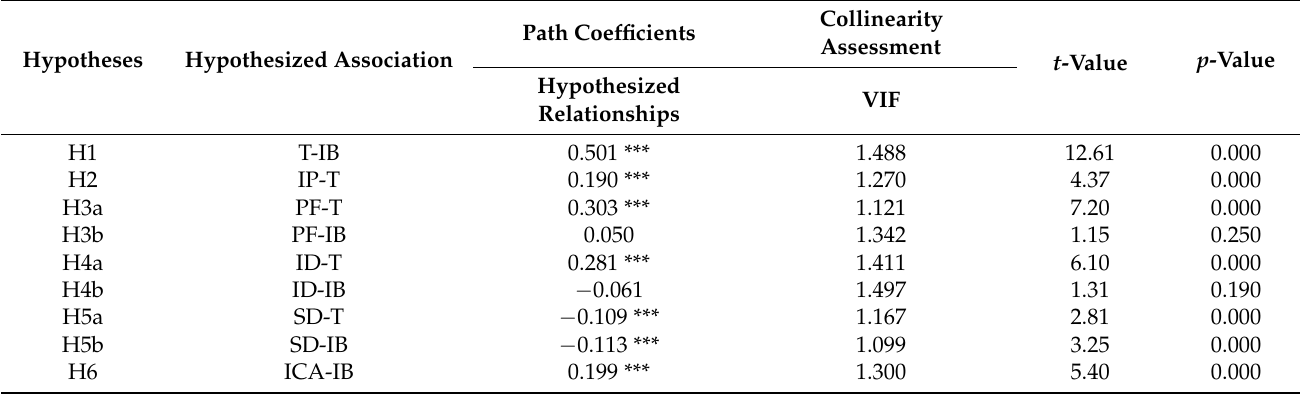
Table 4. Structural model analysis process.